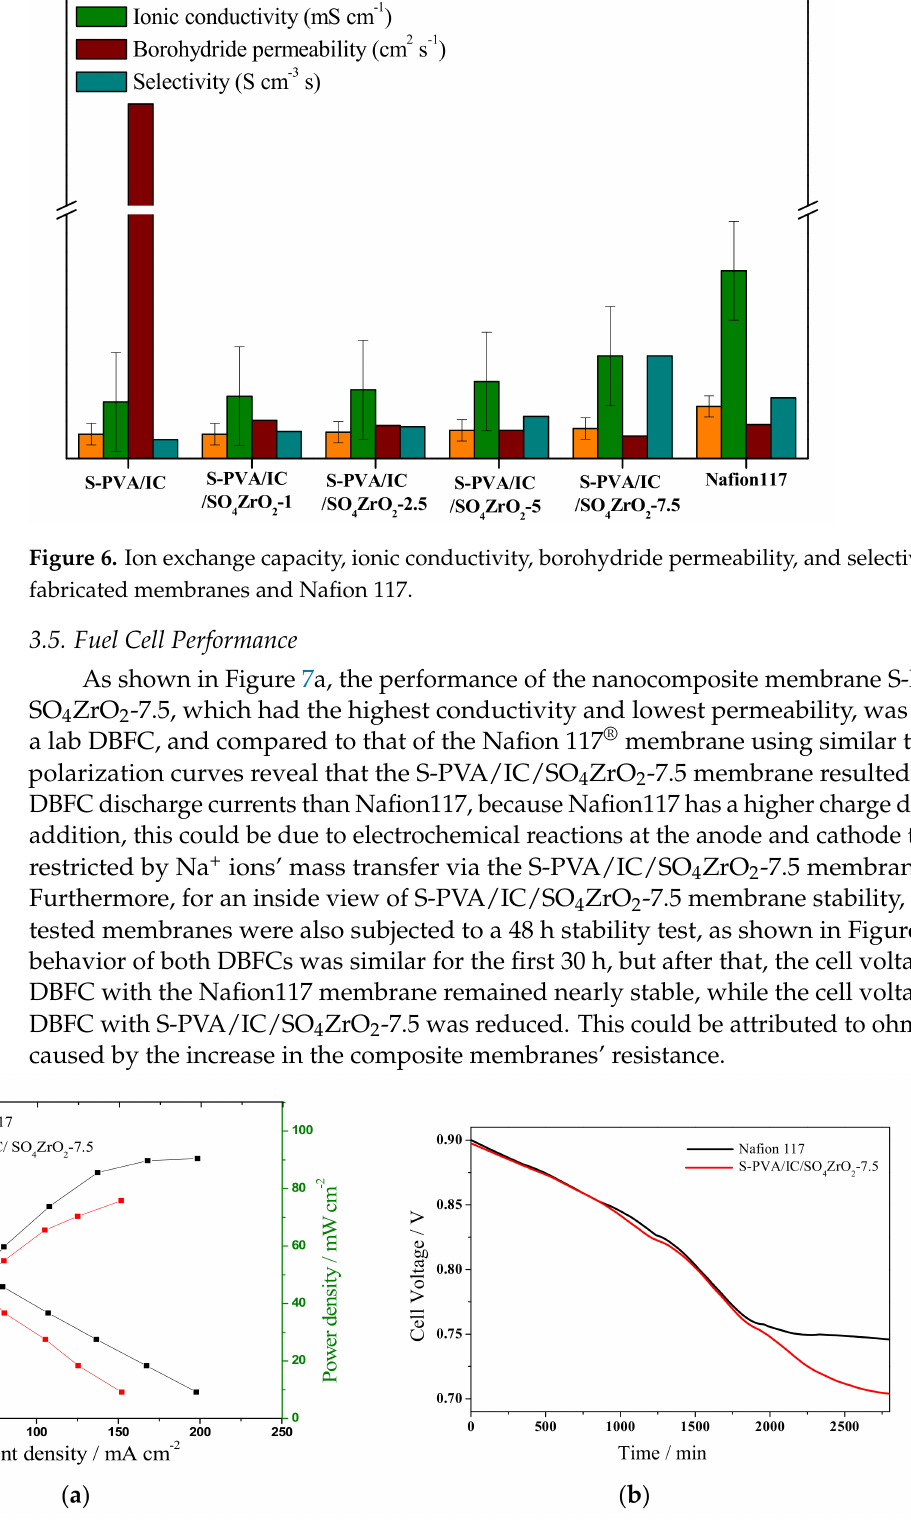
Figure 7. ( a ) Power density curves and polarization of DBFCs, and ( b ) fuel cell stability recorded at a current density of 50 mA · cm − 2 for 48 h, at room temperature, using PVA/IC/SO 4 ZrO 2 -7.5 and Nafion117